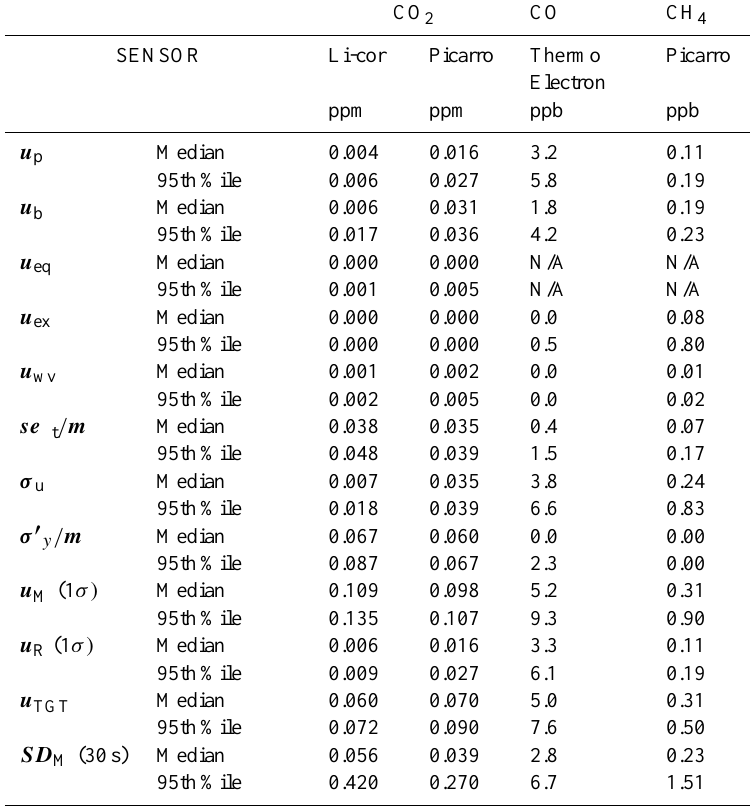
Table 4. Typical values for uncertainty terms (WGC July 2011).